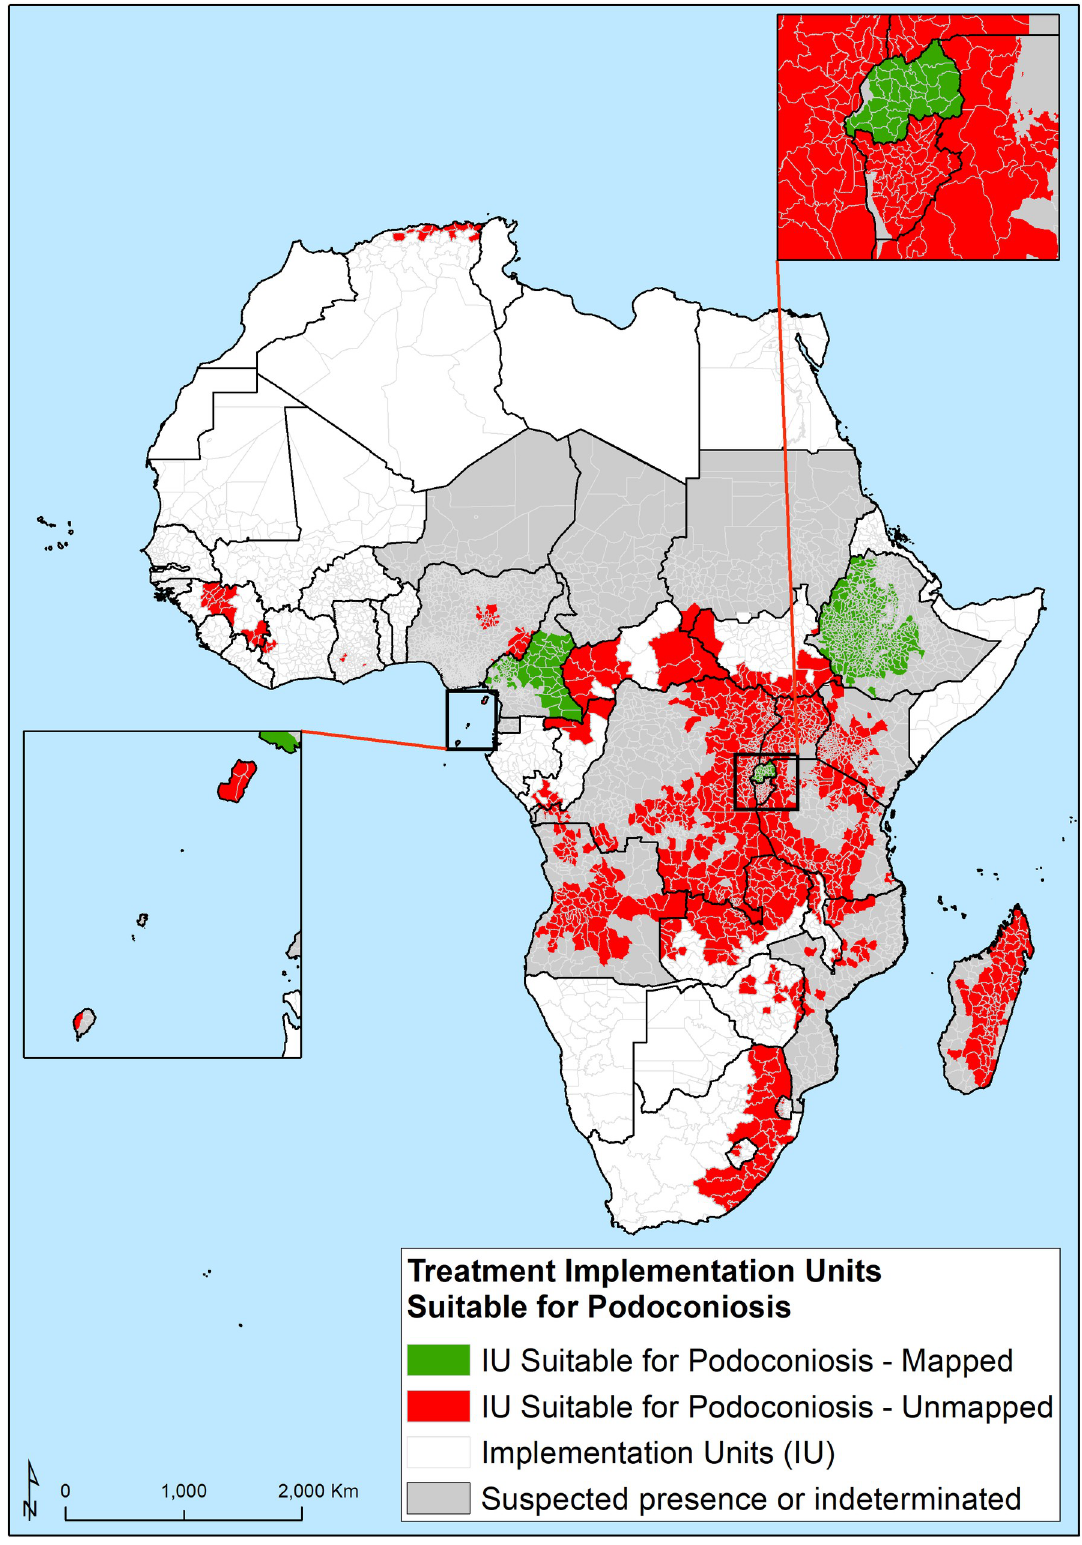
Fig 5. IU-level suitability classification based on WHO geographic units for implementation of control interventions. Red identifies suitable IUs which are not mapped and green identifies suitable IUs mapped for podoconiosis. https://doi.org/10.1371/journal.pntd.0008616.g005 PLOS NeglectedTropical Diseases | https://doi.org/10.1371/journal.pntd.0008616 August 27,